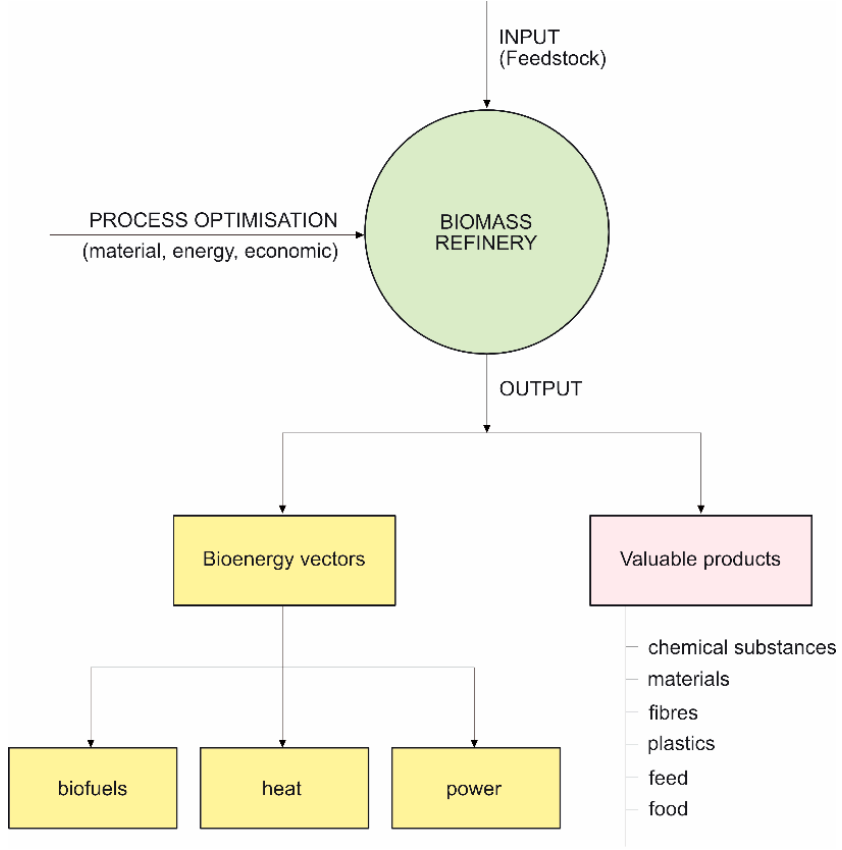
Figure 7. A biomass refinery in the Input/Output (I/O) model.